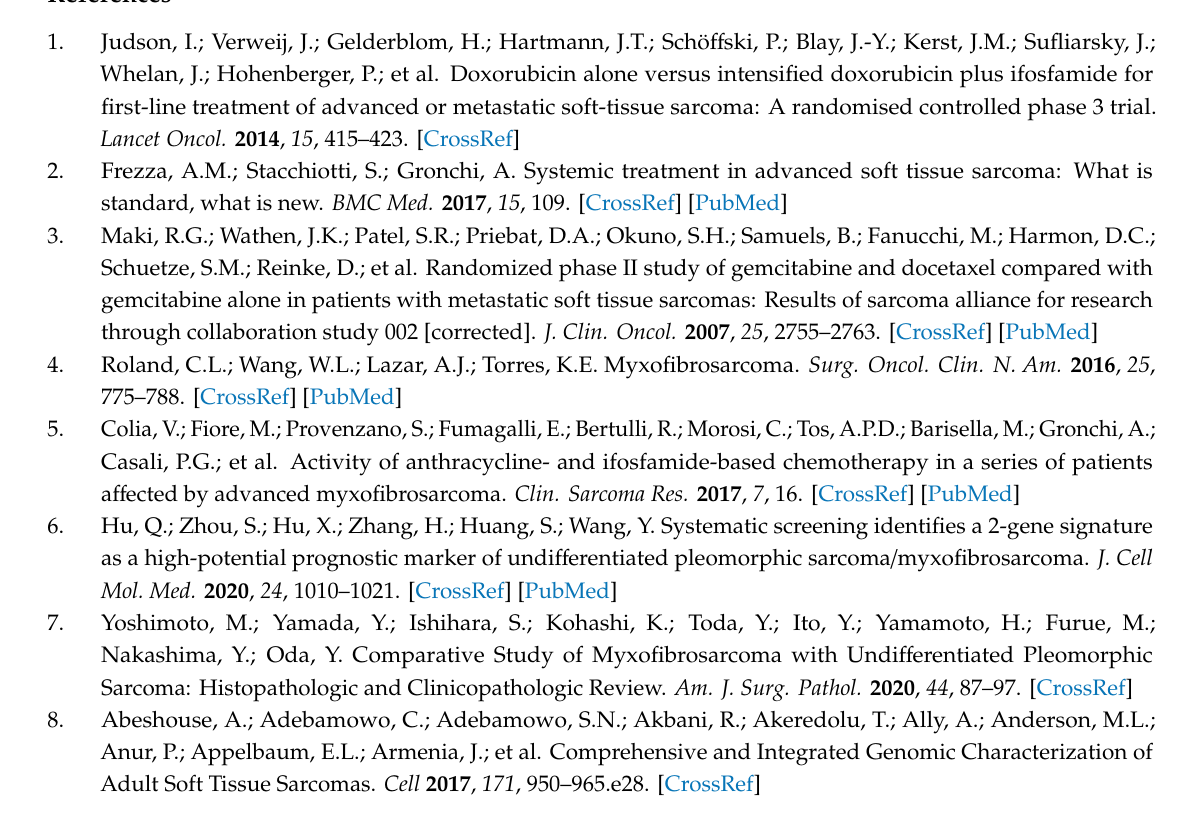
Figure S1: Consort diagram for study